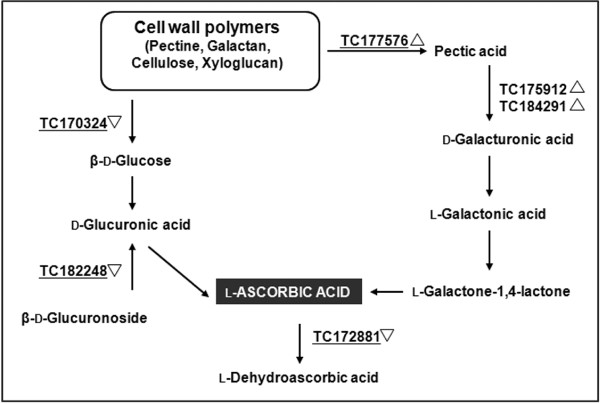
Network showing the differential expression (between IL 12-4 and M82) of genes associated with AsA metabolism in fruit. Underlined TCs are differentially expressed in the microarray experiment, with upright triangles representing upregulation and inverted triangles representing downregulation.